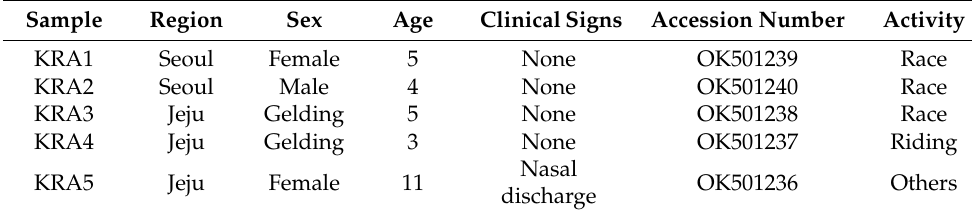
Table 2. Details of PCR-tested EAdV-1-positive horses and amplicon accession